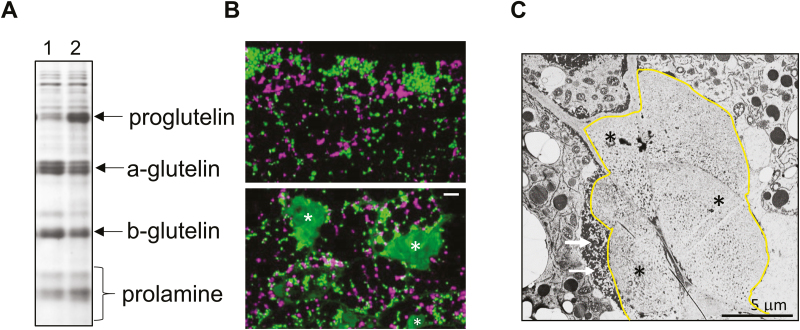
Properties of the rice glup6 mutant lines. (A) SDS-PAGE showing the over-accumulation of proglutelin and reduction in glutelin acidic and basic subunits in the glup6 rice mutant (lane 2) as compared to the wild-type (lane 1). (B) Distribution of prolamine (purple) and glutelin polypeptides (green) in the wild-type (upper panel) and in glup6 (lower panel). In the wild-type, prolamine polypeptides are deposited as intracisternal granules within the ER while glutelins are transported to the protein storage vacuoles. In the wild-type the bulk of storage protein synthesis and accumulations clearly occurs in the outer endosperm (subaleurone) layers. In glup6, glutelins are initially secreted to the cell periphery where they are partially endocytosed to form paramural bodies (PMBs, labeled with asterisks). As the seed develops, glutelins and other endosomal proteins are directly transported and secreted to these novel structures. (C) Transmission electron micrograph of glup6 endosperm depicting a large PMB (outlined in yellow) formed at the junction of three endosperm cells. The arrows show the large number of electron-dense granules bordering the PMB.